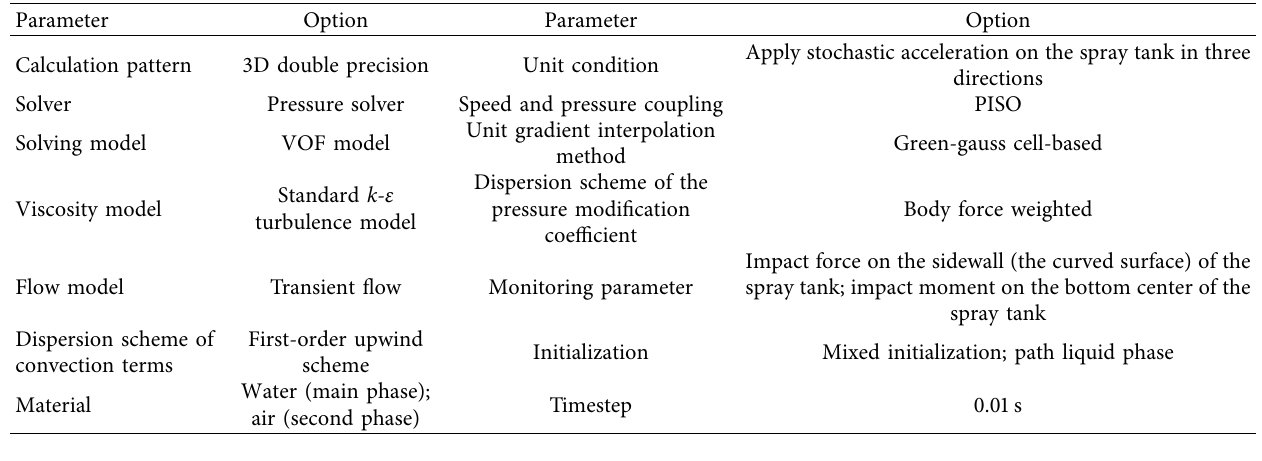
Figure 4: Schematic diagram of the two-phase flow in the spray tank. Table 3: Fluent simulation